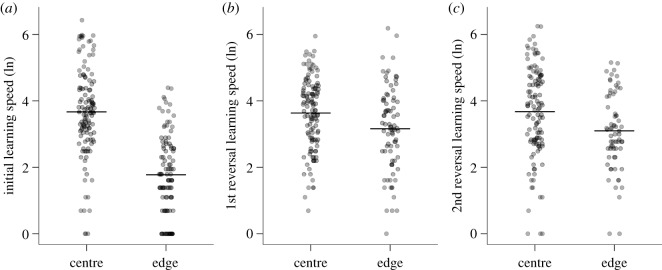
Effects of the location of the feeder on individual learning speed for (a) initial learning, (b) the first reversal and (c) the second reversal. Points represent individual birds (points have been jittered along the x-axis and rendered partially transparent to reduce overlap; as a result, any remaining overlap results in darker points). Horizontal line represents the mean value. Learning speed is the number of visits to criterion; therefore, lower values represent faster learning.